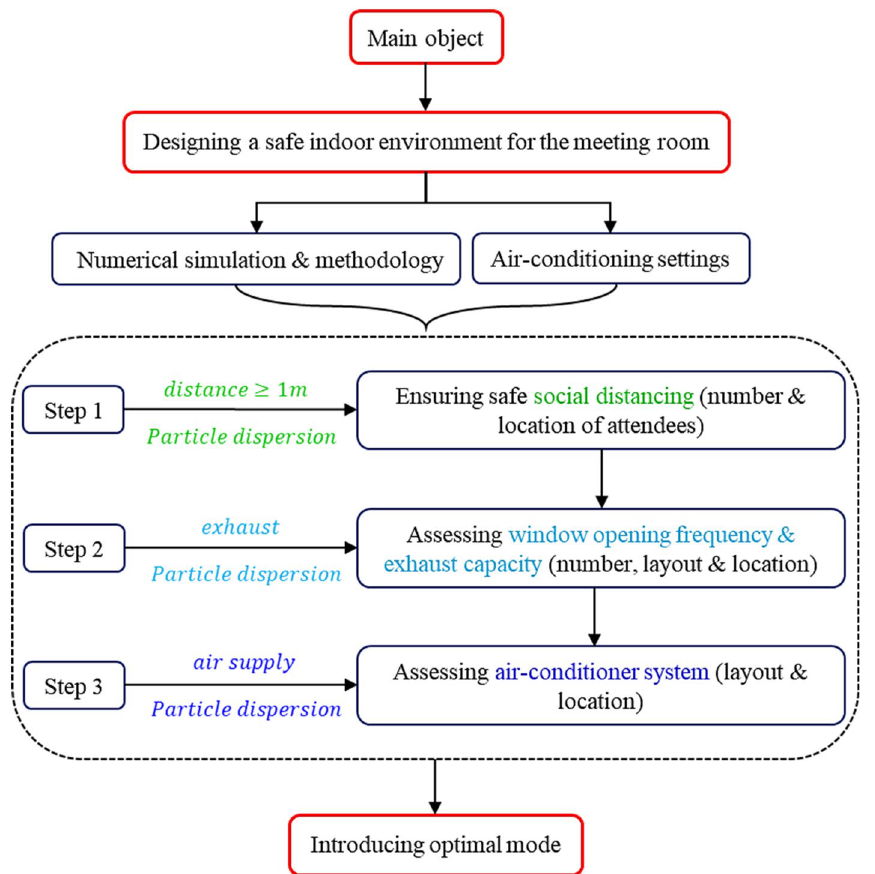
Figure 1. Flowchart of present study aimed at air-conditioned meeting room design for a safe indoor